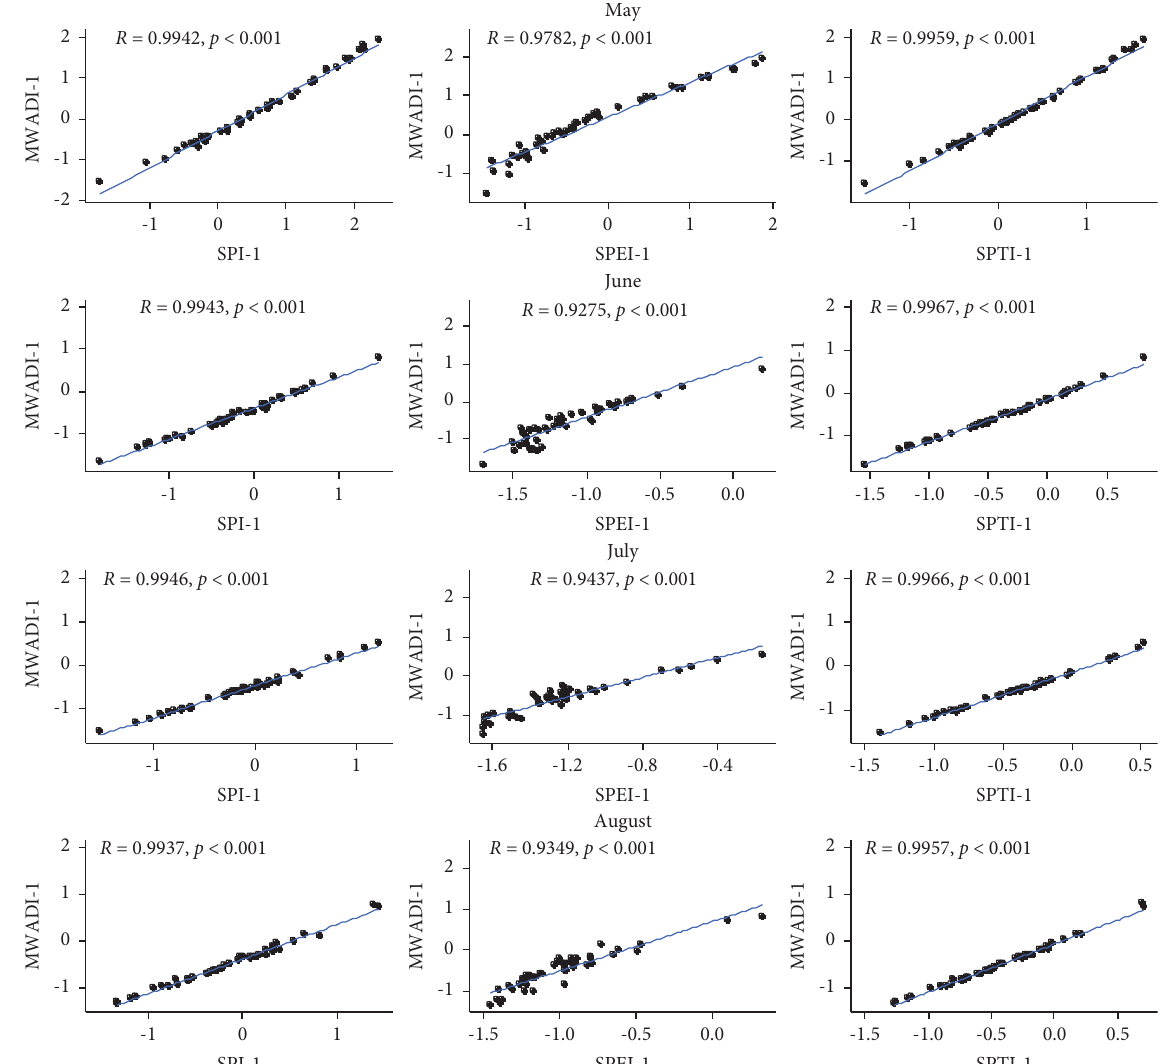
Figure 5: Te scatter diagram and correlation coefcient R values between the seasonal MWADI and the SPI, the SPEI, and the SPTI (May–August) at